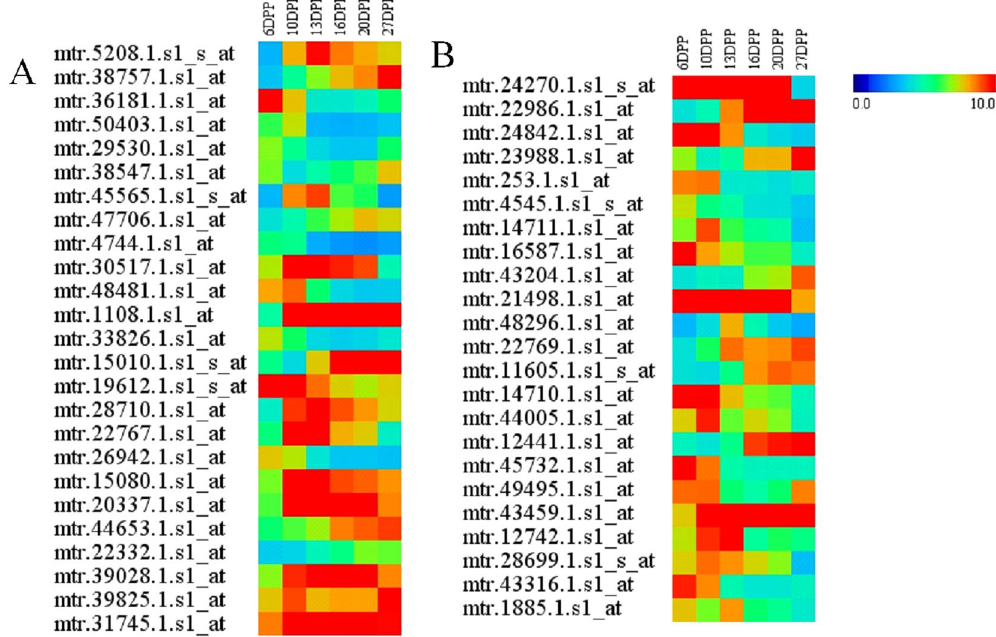
Figure 5. Expression profiling of MYB and bHLH families during MC development. Relative expression values were used to construct the heat map. ( A ) shows the expression profile of the MYB family. ( B ) shows the expression profile of the bHLH family. Additional information regarding the transcriptional factor genes is presented in Table